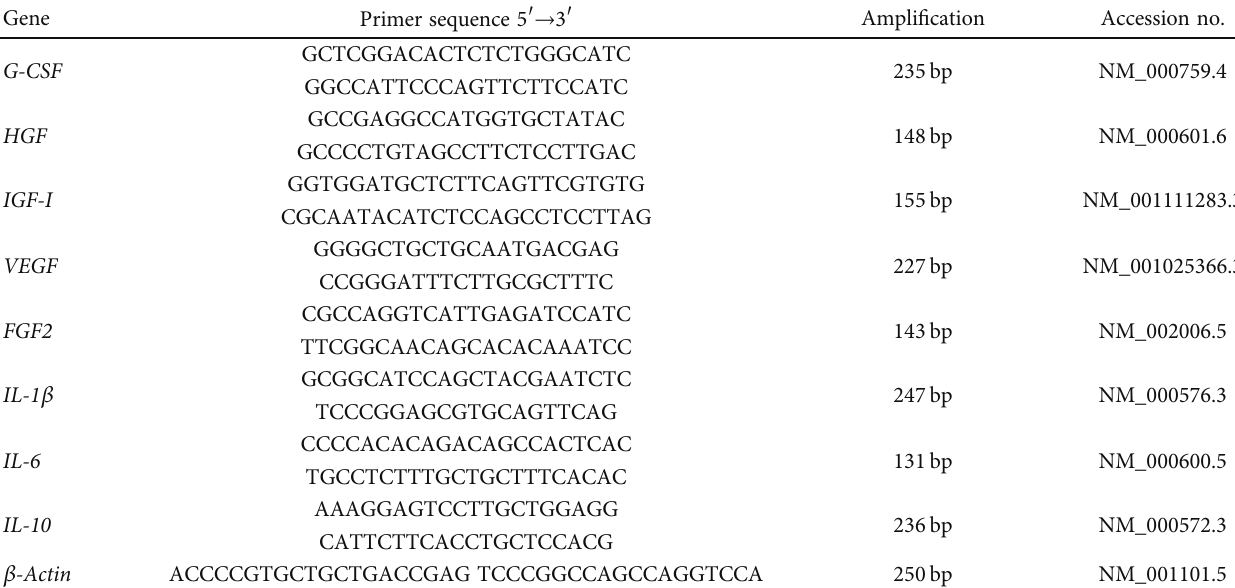
Table 1: Primer sequences for